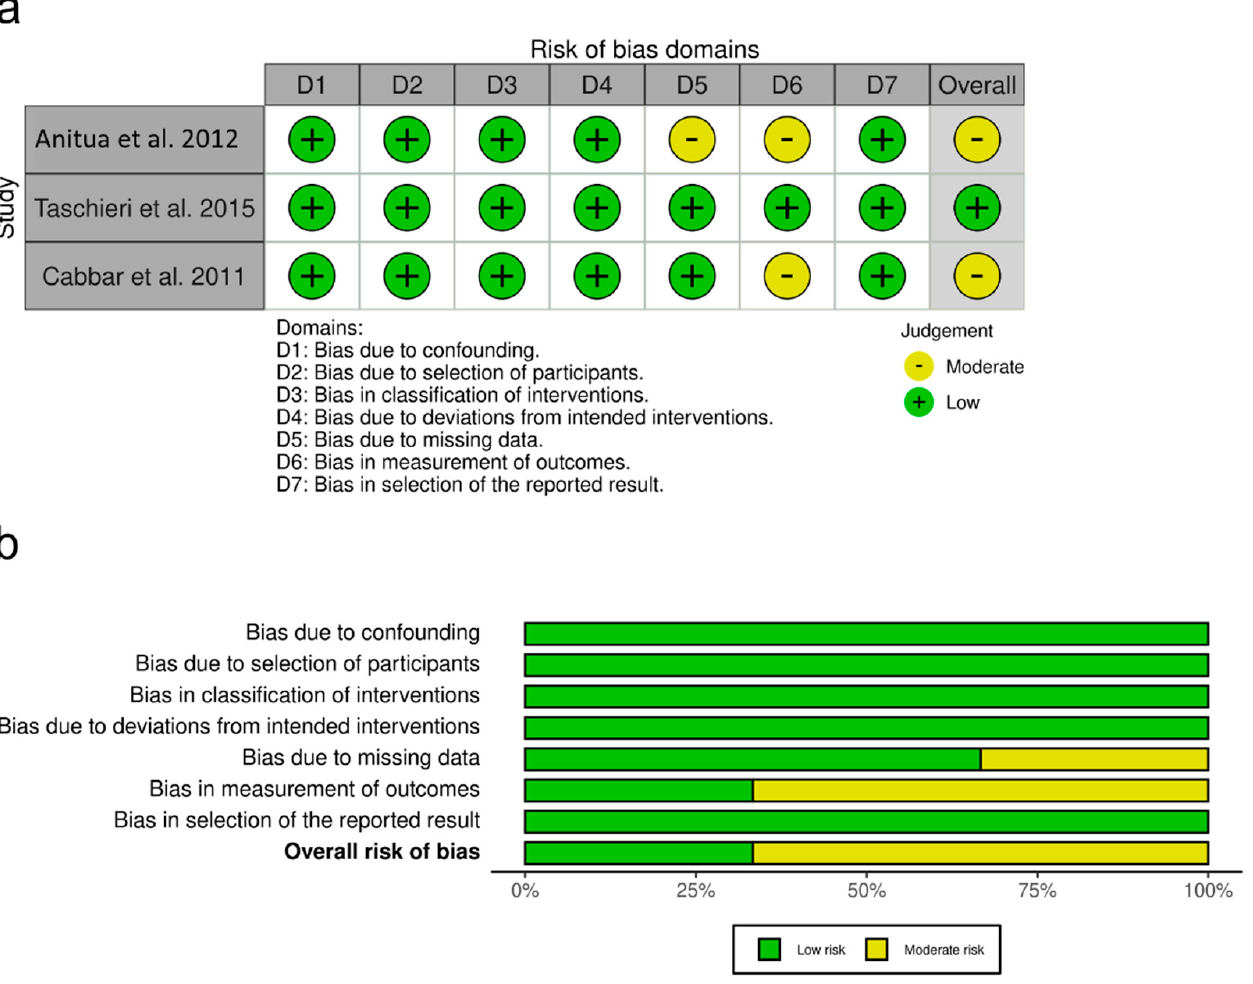
Figure 3. Quality assessment of the included prospective non-randomized studies. ( a ) Risk-of-bias summary, review of authors’ judgments about each risk-of-bias item for each included study. (+): moderate risk of bias. ( b ) Risk of bias graph, review of authors’ judgments about each risk-of-bias item, presented as percentages across all included studies